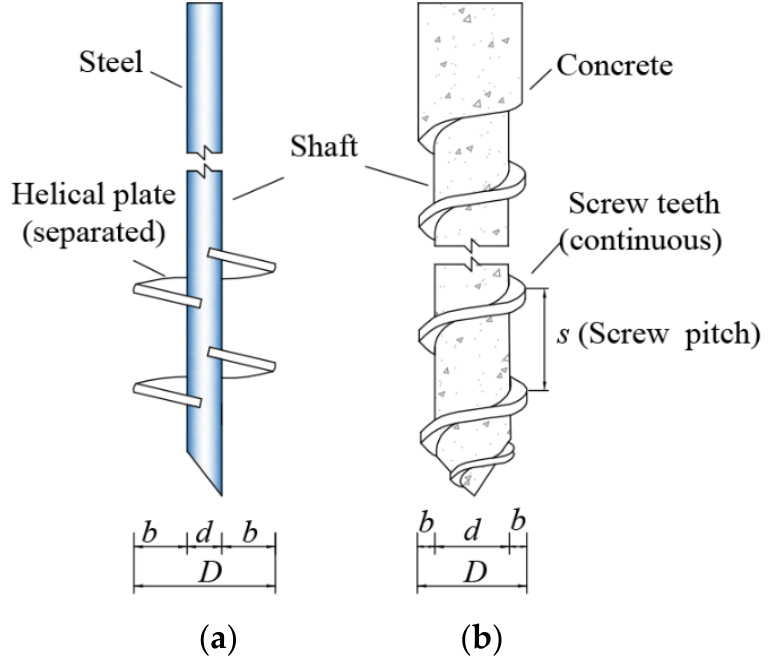
Figure 1. Schematic diagram. ( a ) Steel screw pile and ( b ) concrete screw pile